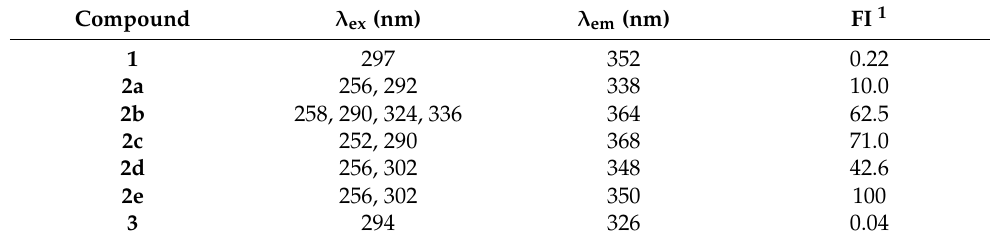
Table 1. Native fluorescence parameters of the compounds studied in ethanol.